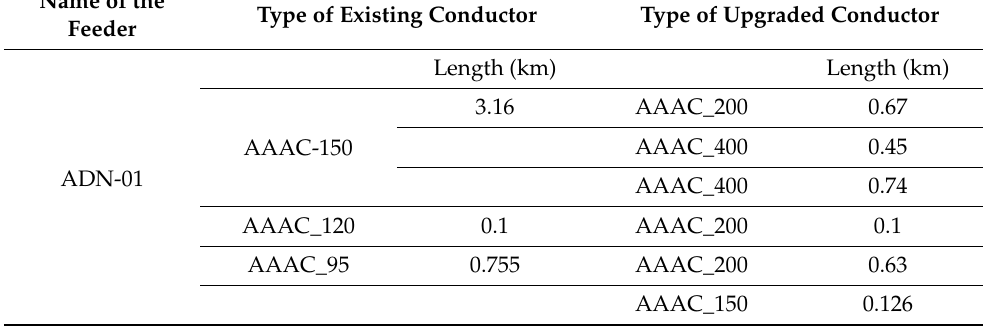
Table 4. Upgraded conductors of existing feeders in case of demand in 2030GC.